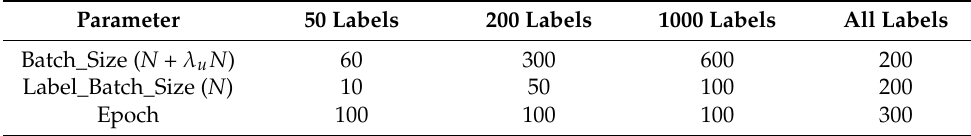
Table 3. Experimental parameter